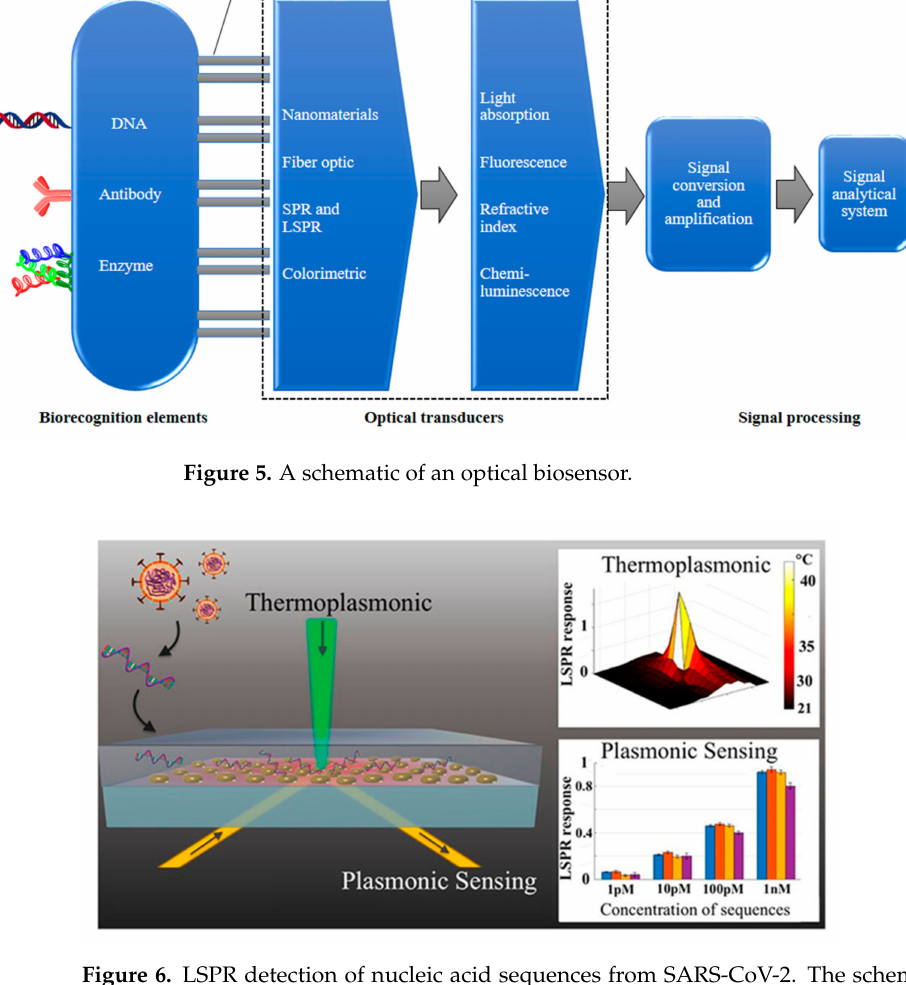
Figure 6. LSPR detection of nucleic acid sequences from SARS-CoV-2. The schematic shows